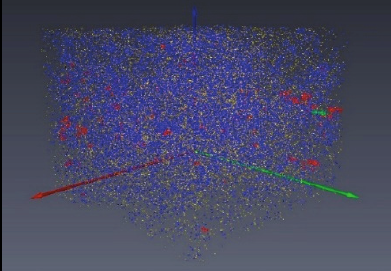
Fig. 7. Microtomographic image of Devonian sandstone pore space (subsample B); Avizo application, OGI-NRI in